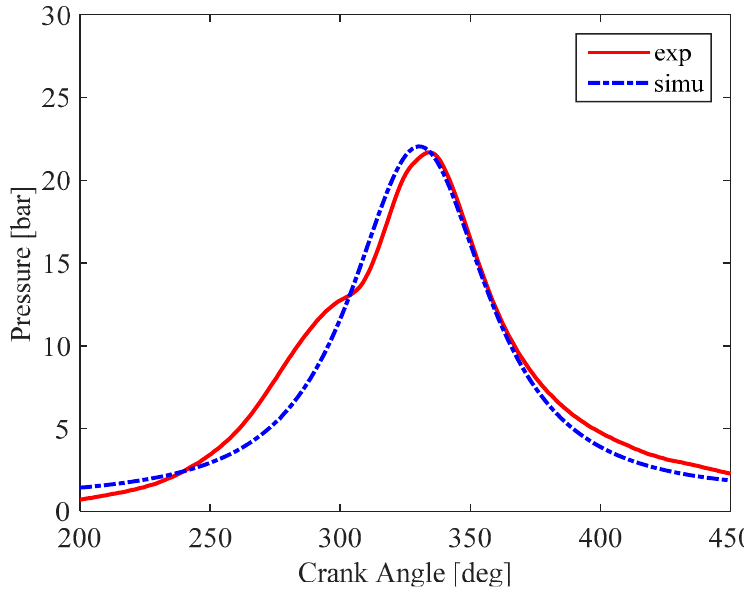
Figure 7. In-cylinder pressure vs. crank angle for the experiments (solid red line) and simulations (dash blue line).